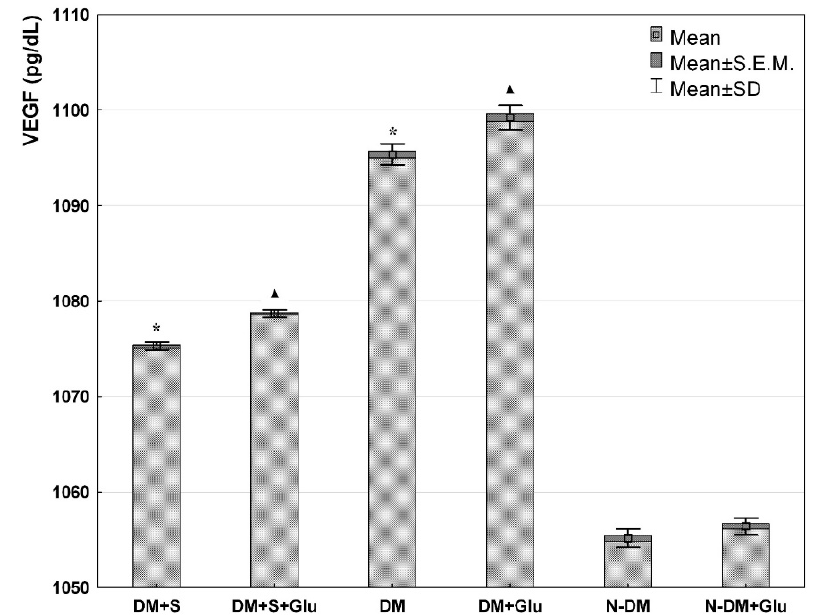
Figure 1. VEGF level in the supernatant from a culture of human PBMCs isolated from statin-treated or statin-free type 2 diabetic patients, or from non-diabetic controls in the medium only, or preincubated with glucose (ANOVA). *—statistically significant difference compared with other groups at basic conditions, for p ≤ 0.05 ; ▲ —statistically significant difference compared with other groups in the presence of glucose, for p ≤ 0.05.